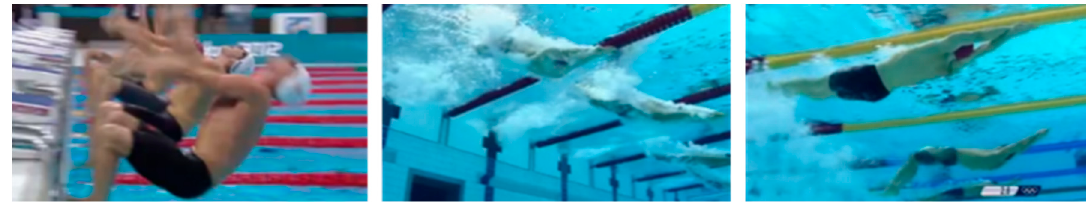
Figure 1. Example video with a human-annotated sentence—“a group of swimmers are swimming fast”.